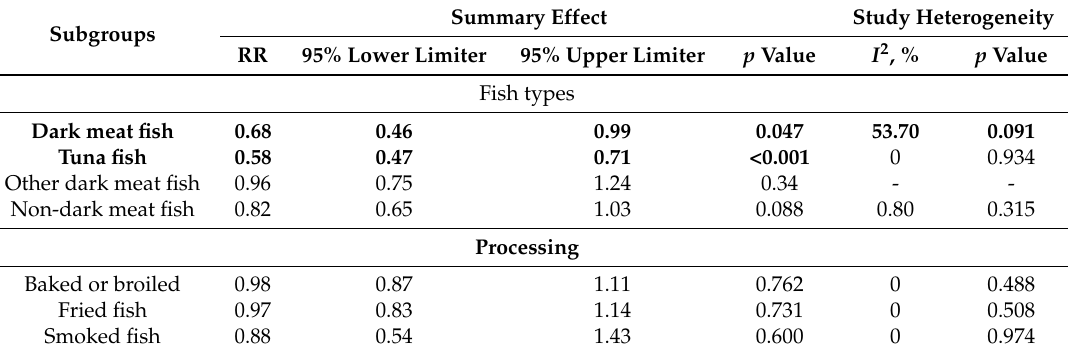
Table 3. Stratified analysis of fish subtypes and processing methods and risk of AMD with combined